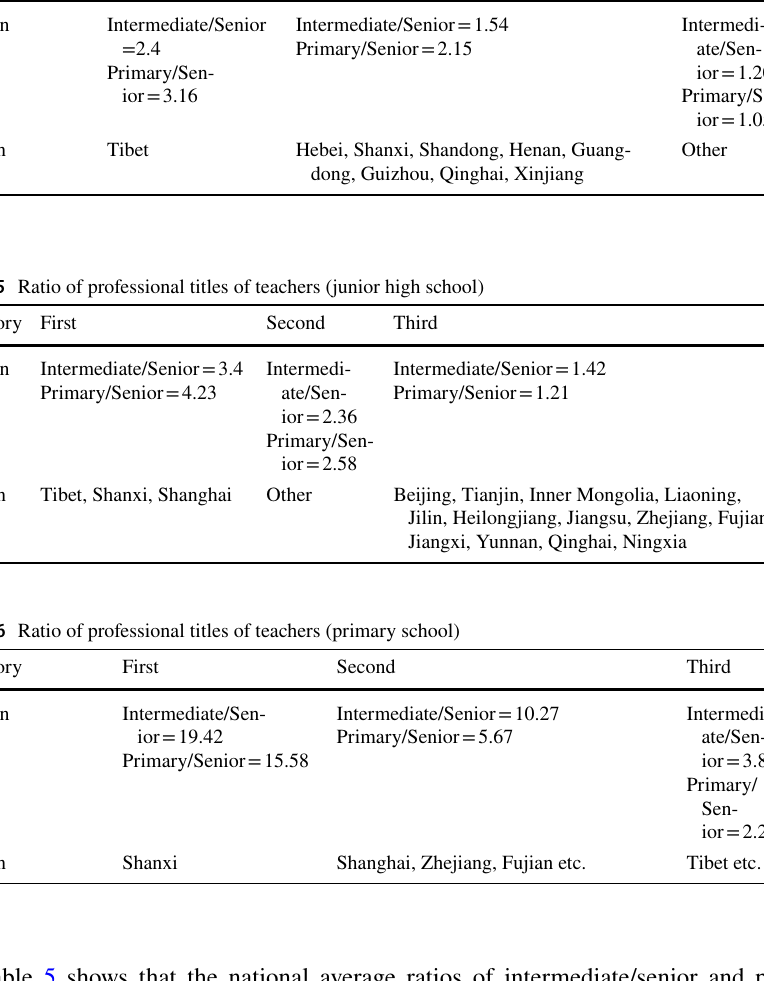
Table 4 Ratio of professional titles of teachers (senior high school) Category